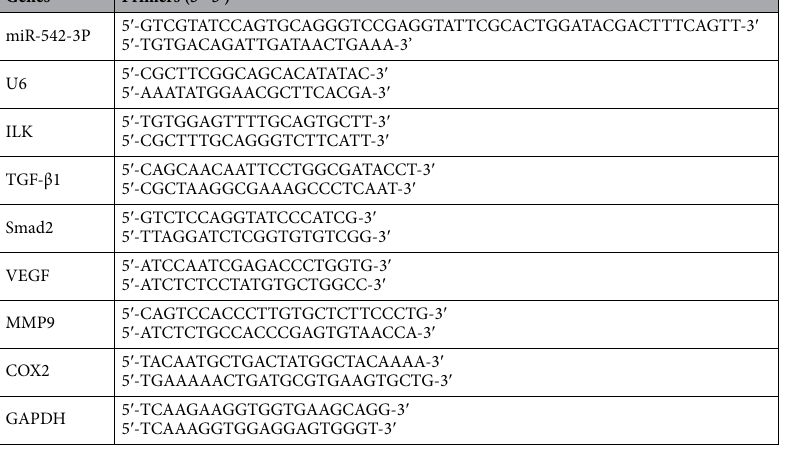
Table 1. Primers for q-PCR in our